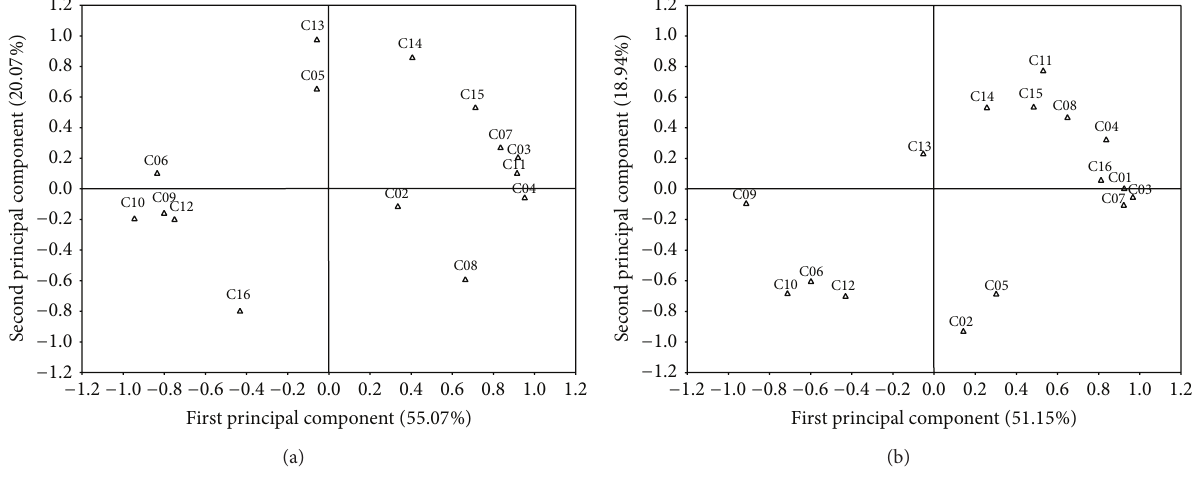
Figure 5: Distribution of the chemical constituents of the essential oil of L. gracilis in relation to the two principal components through analysis of the principal component analysis (PCA) for plants cultivated with (a) and without (b) irrigation. (C01 = 𝛼 -thujene, C02 = myrcene, C03= 𝛼 -terpinene,C04=p-cymene,C05=limonene,C06=1,8-cineol,C07= 𝛾 -terpinene,C08=linalool,C09=methylthymol,C10=thymol, C11 = carvacrol, C12 = 𝛽 -caryophyllene, C13 = 𝛼 -humulene, C14 = bicyclogermacrene, C15 = spathulenol, and C16 = caryophyllene